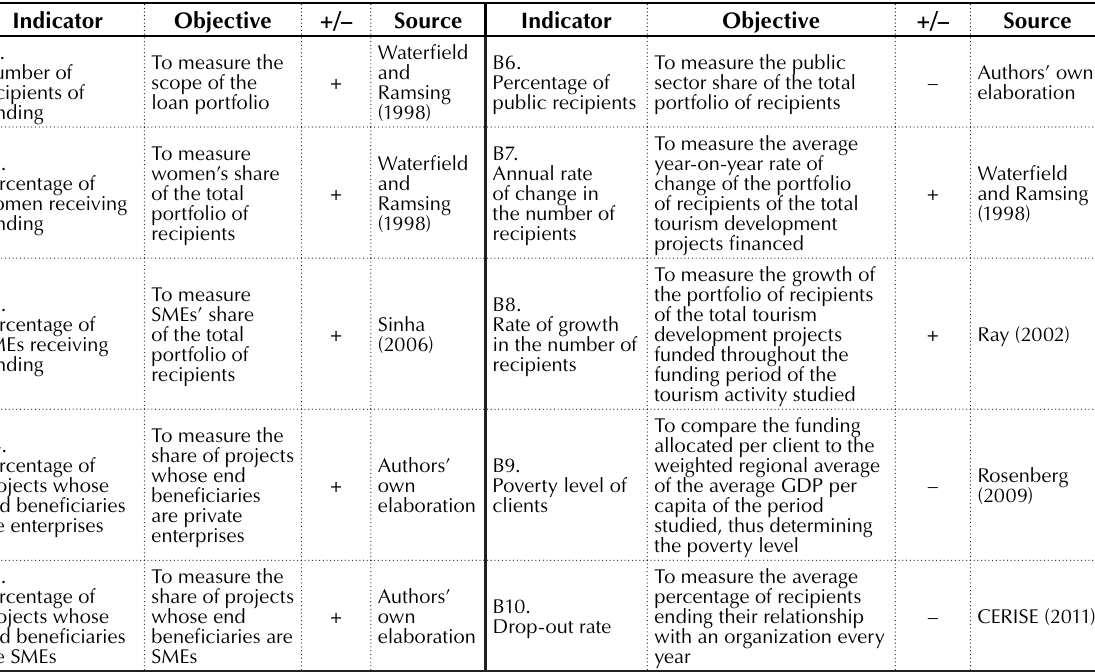
Table 3. Indicators of the scope and growth of the portfolio of clients and end beneficiaries of the funding